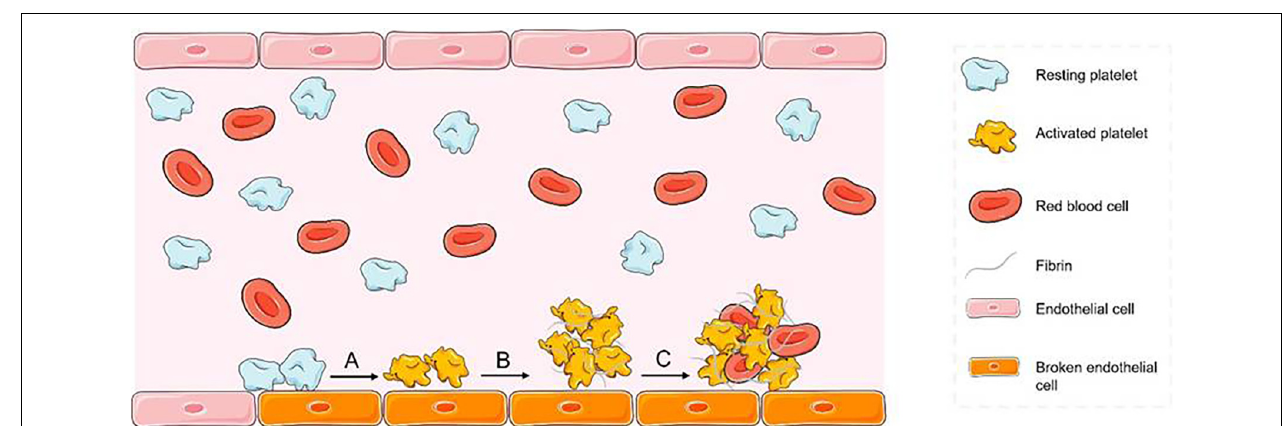
FIGURE 6 | Mechanism of thrombosis diagram (A) platelets adhere to the exposed collagen surface after endothelial injury and are activated by collagen. (B) After aggregation of activated platelets, they are tightly intertwined with fibrin. (C) The initially formed thrombus nets the red blood cells and other substances in the blood.